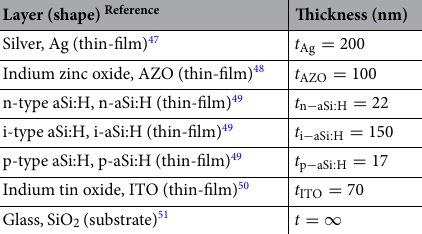
Table 1. Layer structure of ultra thin a-Si:H solar cell (from bottom to